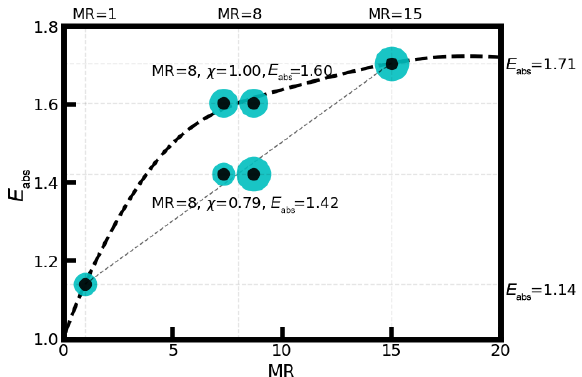
Figure 6. Schematic diagram that denotes the relationship between χ and E abs .